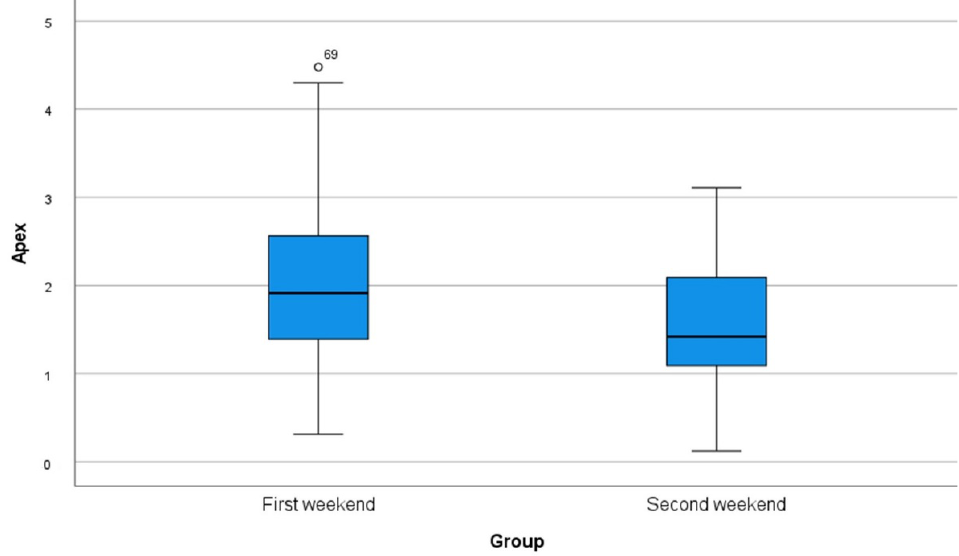
Figure 6. Box plot of all measurements of deviations in the exact positions in cranial/caudal direction (apex) regarding the master typodont. Table 2. Responses of the ten students regarding subjective reliability in using a dynamic computer- assisted surgical system in dental implant placement (first session).